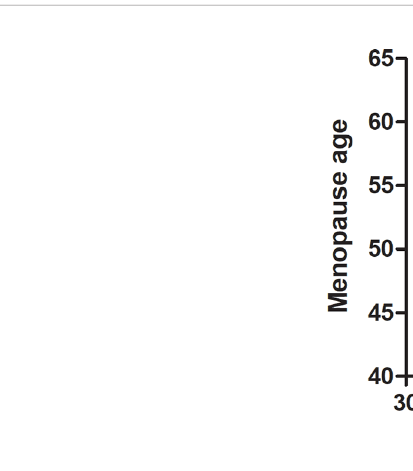
FIGURE 2 | Correlation between menopause age with the onset age of RA